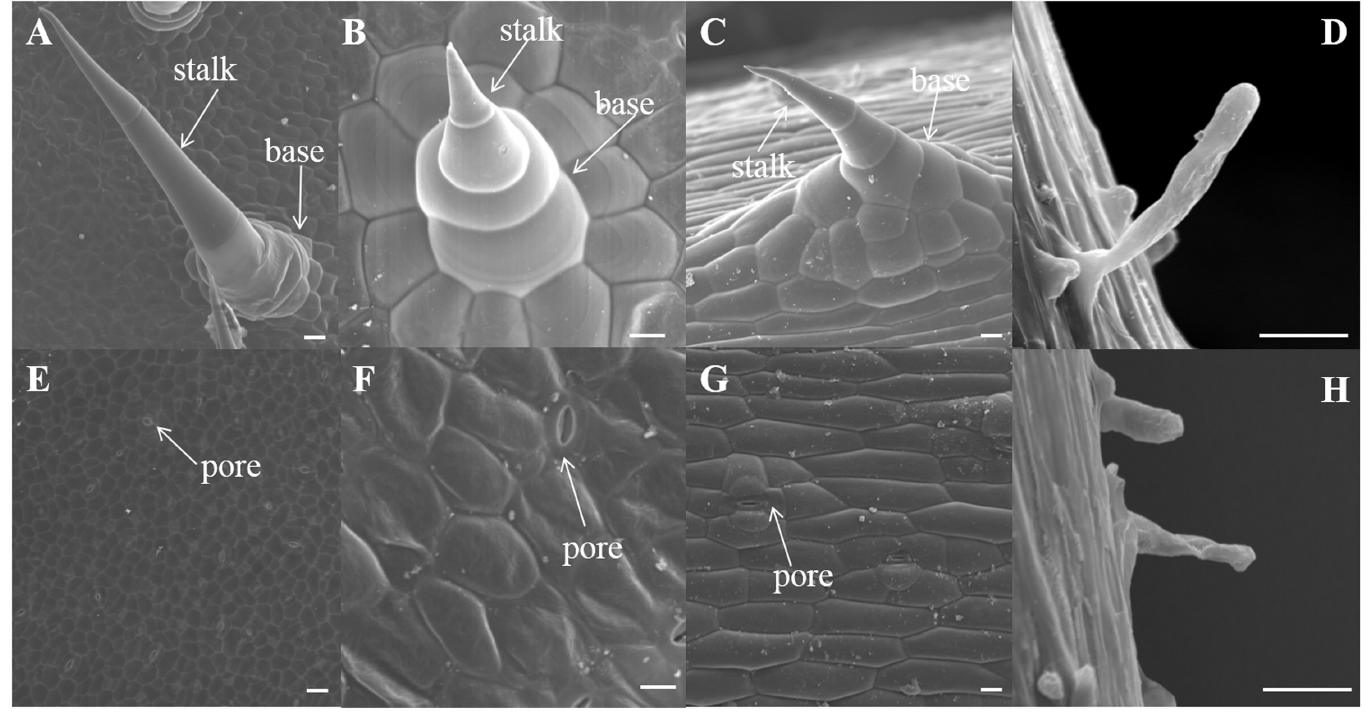
Fig 2. SEM images of leaf (A,E), cotyledon (B,F), stem (C,G) and root (D,H) in 9930 and NCG157. Bars, 100 μ m (A-H).